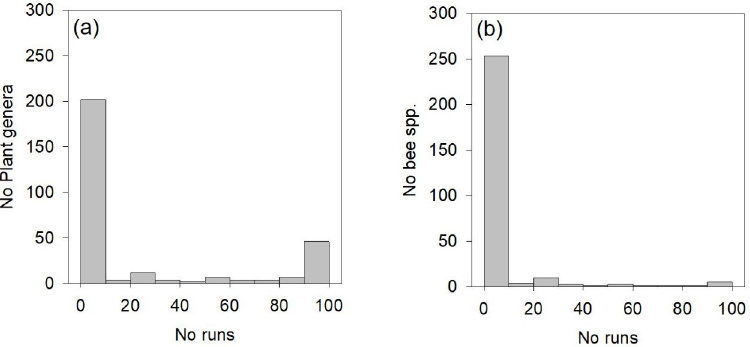
Fig 4. Number of runs in which (a) plant genera or (b) bee species is placed in the same module as honey bees.